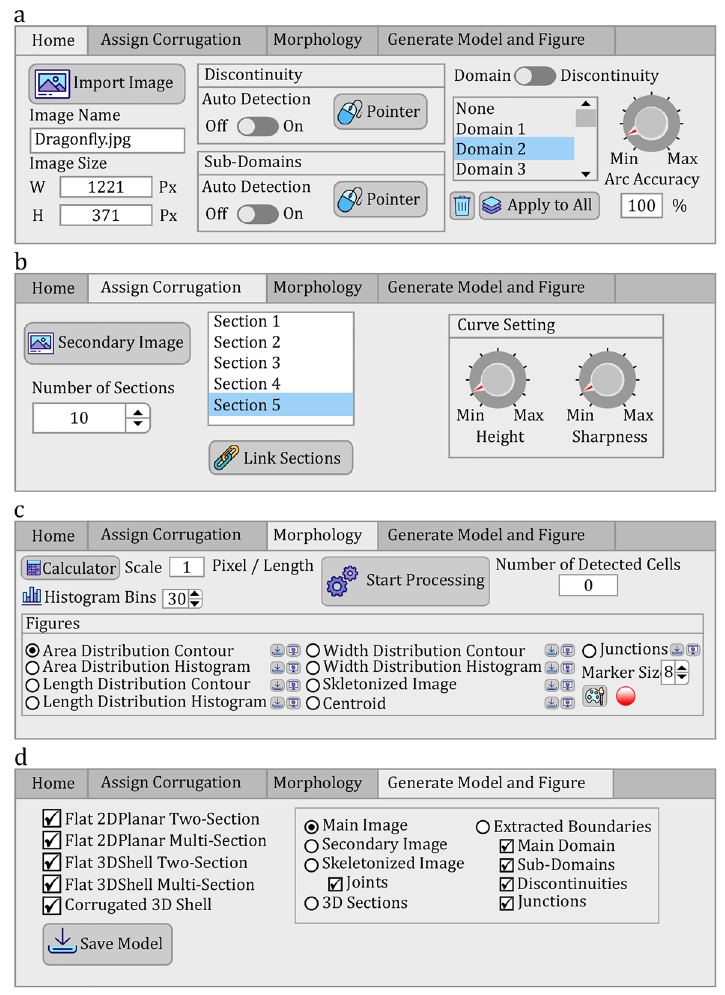
Figure 3. The user interface of WingGram . ( a ) This tab is embedded to import the image, specify the discontinuity and subdomains, and change the number of points on the detected boundaries. ( b ) The user can import the secondary image to assign corrugations in this tab. Two knobs are embedded to change the height and the sharpness of the corrugation. ( c ) This tab is embedded to extract the morphological properties of the insect wing. ( d ) Using this tab, the user can save the FE model of the wing. (icons made by Freepik from www. flati con.